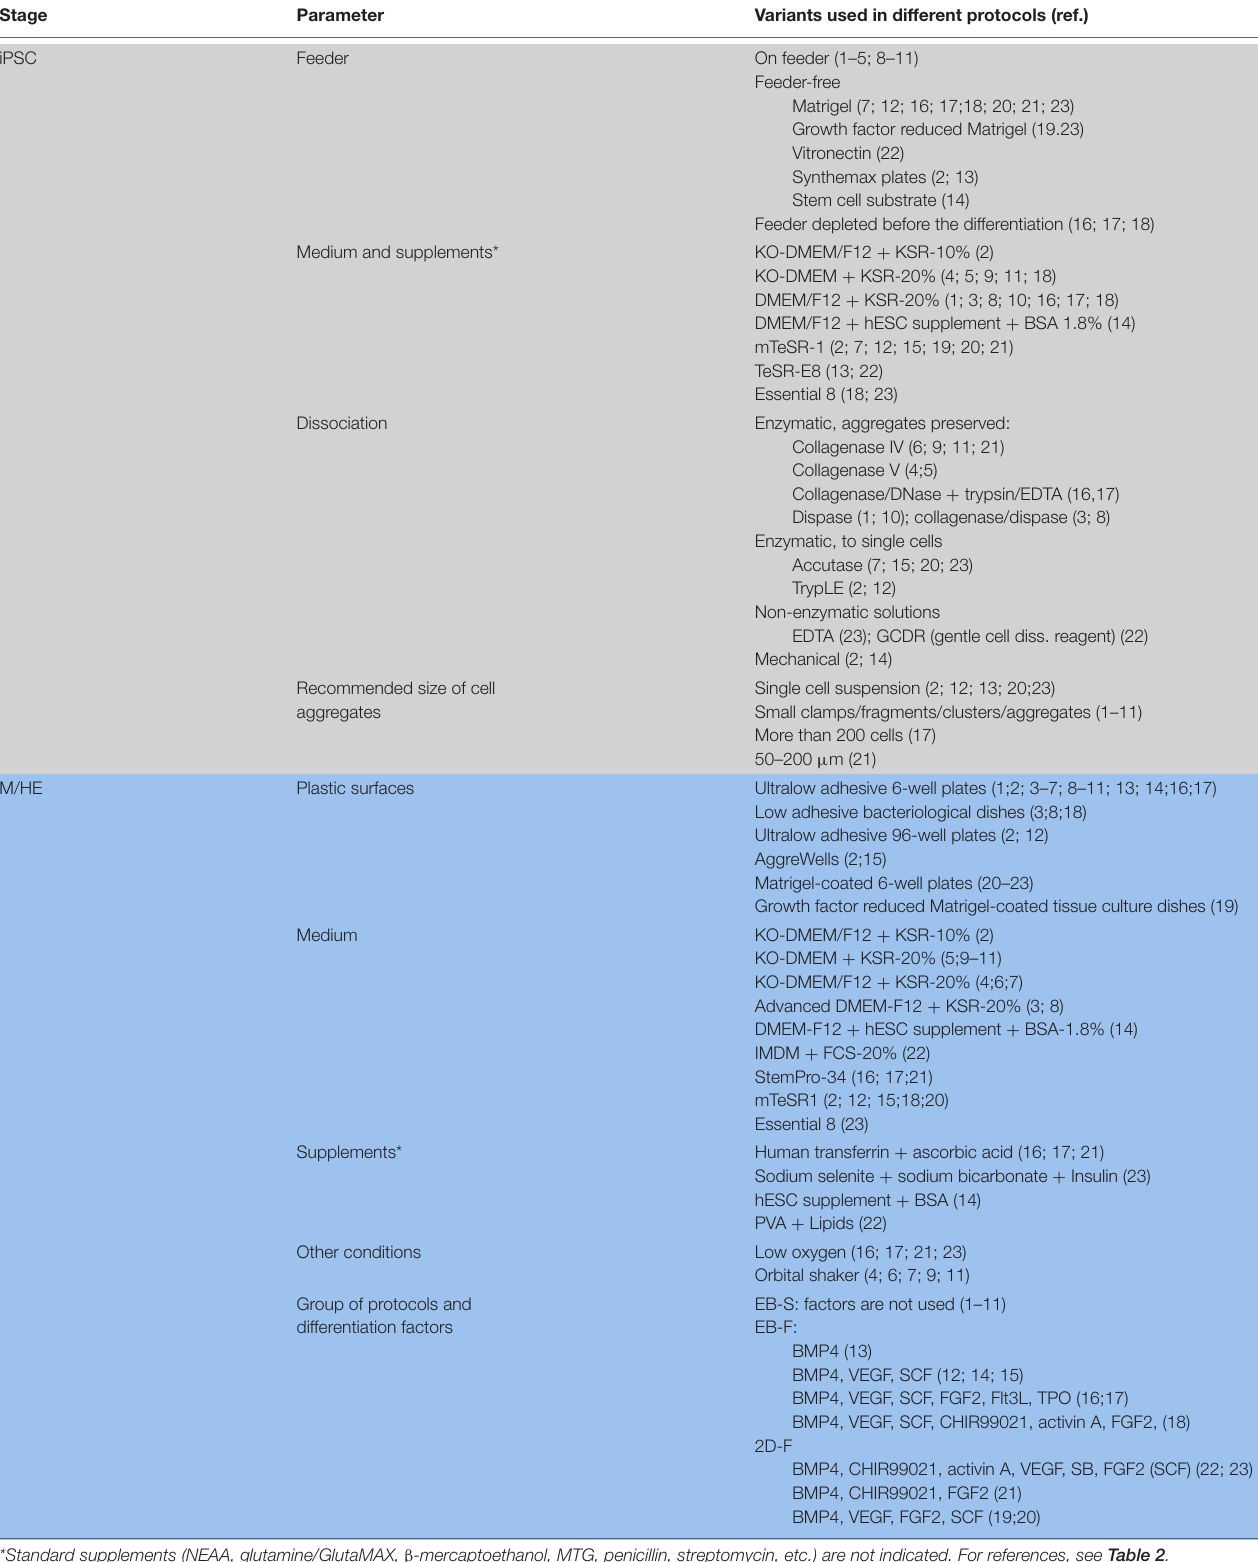
TABLE 1 | Variability of iMPh differentiation protocols during iPSC expansion and M/HE stage. Stage Parameter Variants used in different protocols